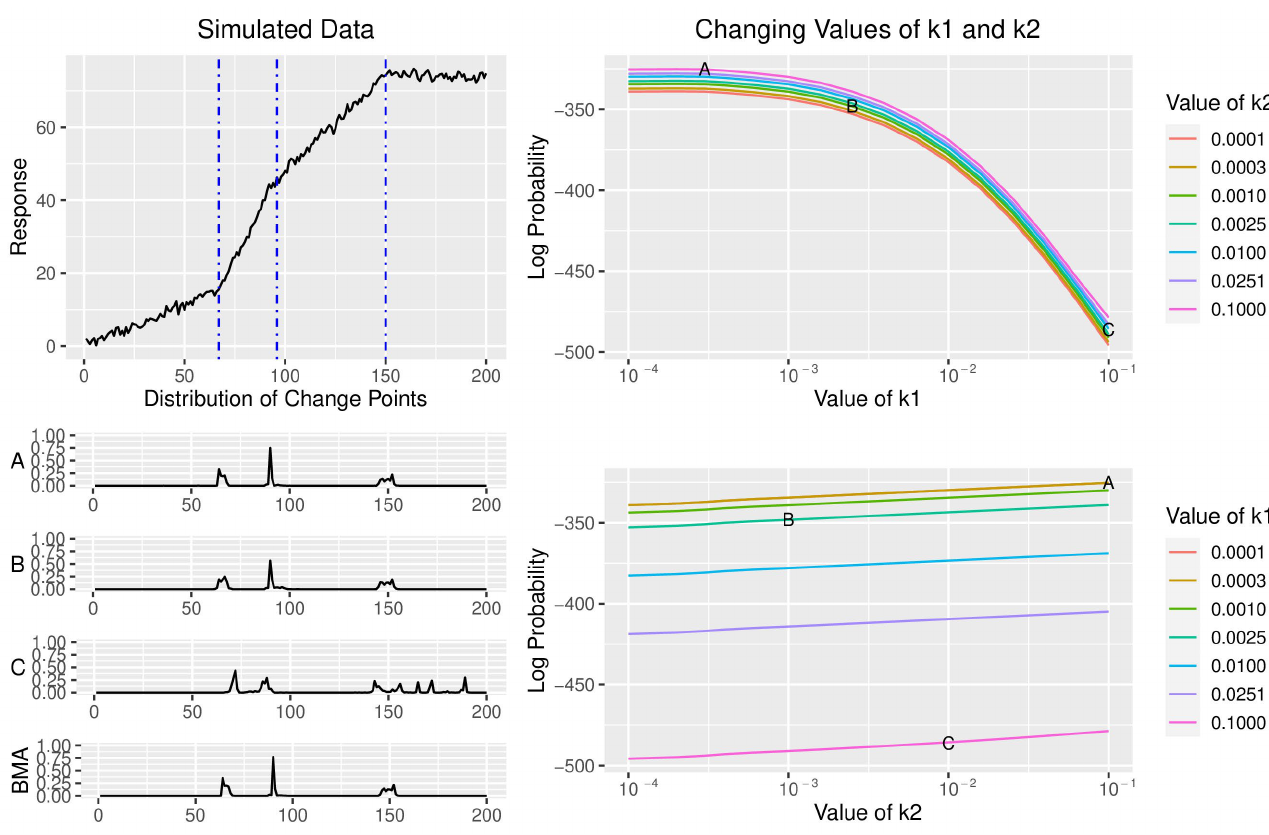
Figure 3. How k 1 and k 2 Affect the Posterior Distribution. The top left displays a dataset generated according to the process described in Section 3.1, along with the location of each change point, indicated as a dotted vertical line. The log probability of the data, i.e., P ( M i | Y ) , is shown on the right for various combinations of v 0 and σ 2 . Three sets of hyperparameters, labeled A, B, and C, are selected and their posterior distribution of the location of change points is shown in the bottom left, along with the posterior distribution for the BMA solution, which weights each solution according to its probability.